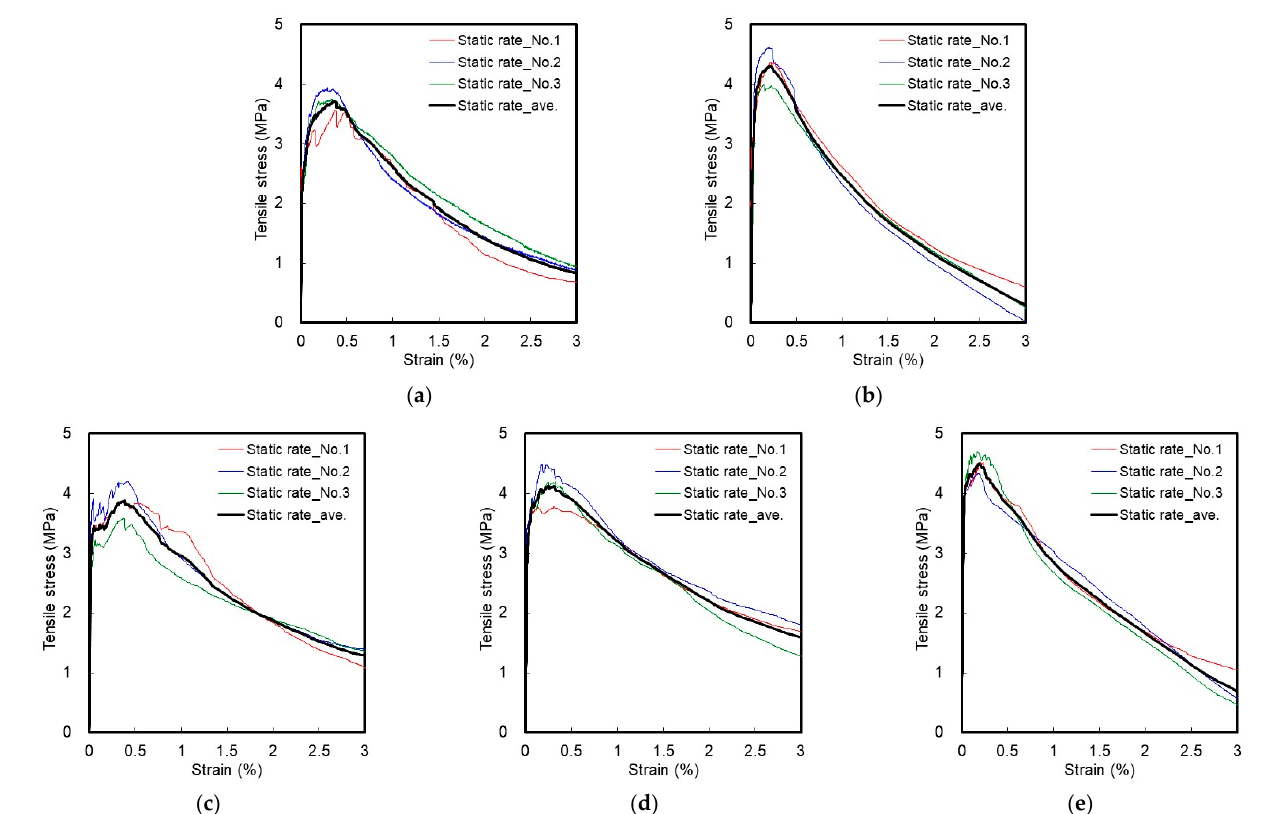
Figure 6. Tensile stress–strain curve at the static rate: ( a ) H2.0; ( b ) S2.0; ( c ) H1.5S0.5; ( d ) H1.0S1.0; ( e ) H0.5S1.5.